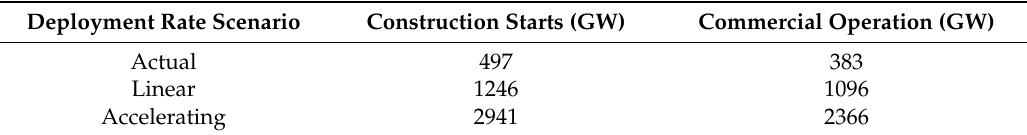
Table 2. Actual and projected cumulative global capacity of construction starts and global capacity in commercial operation in 2015 for the three scenarios.